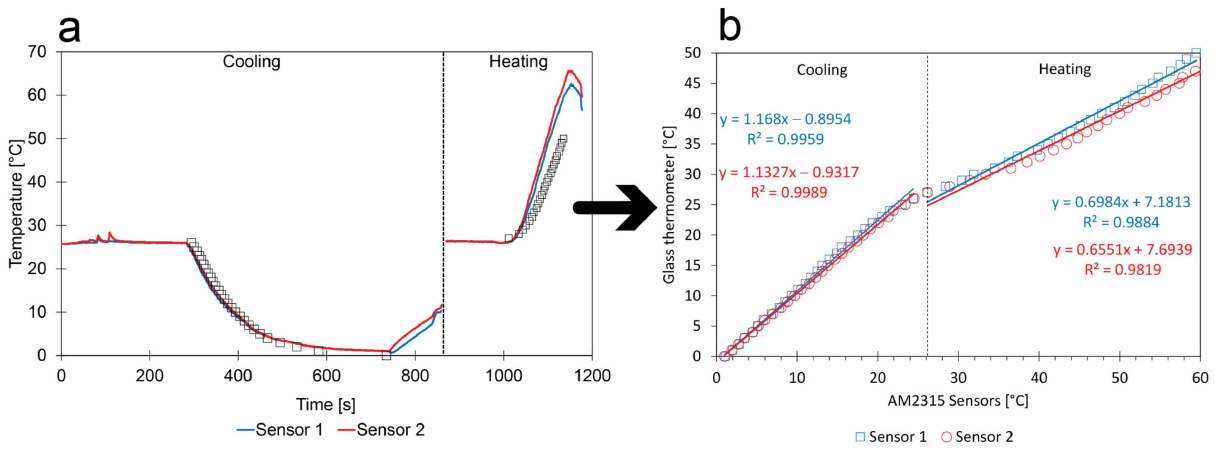
Figure 7. Calibration curves obtained for two AM2315 sensors using a glass thermometer as a reference device. The arrow illustrates the data processing process that converts the raw data into a calibration curve. Visualizing that process helps to regenerate the calibration curve from the same data by others (i.e., reproducibility). The experiments were performed in Cuba (tropical climate); ( a ) raw data of the two sensors obtained during the cooling and heating experiment; ( b ) calibration curves obtained from the raw